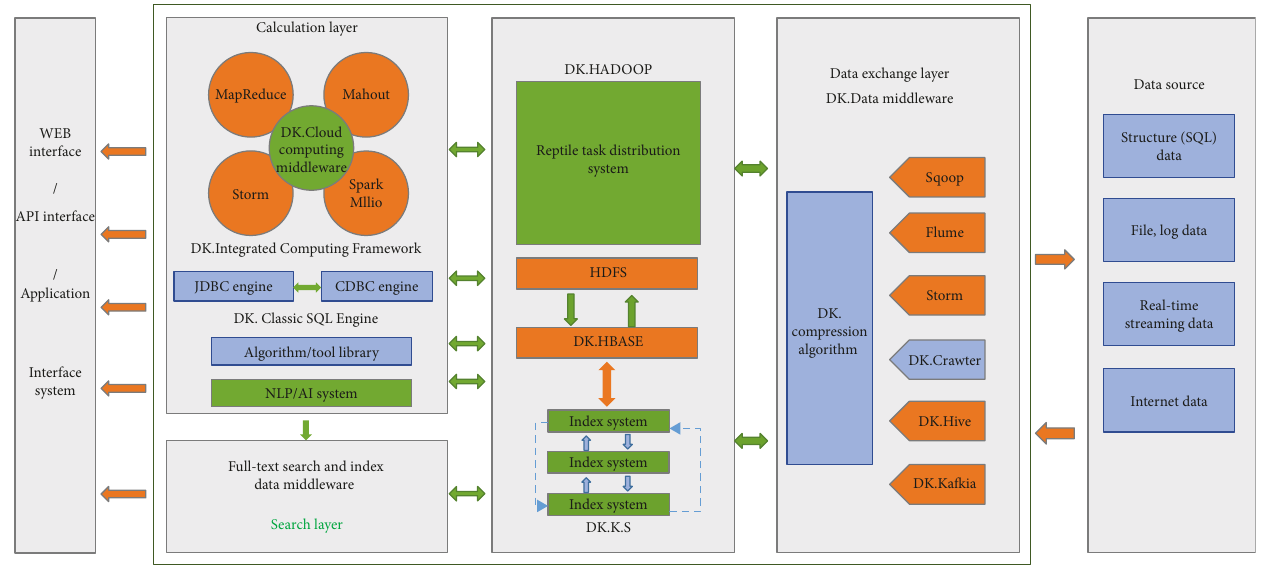
Figure 3: The overall framework of HDFS system structure.